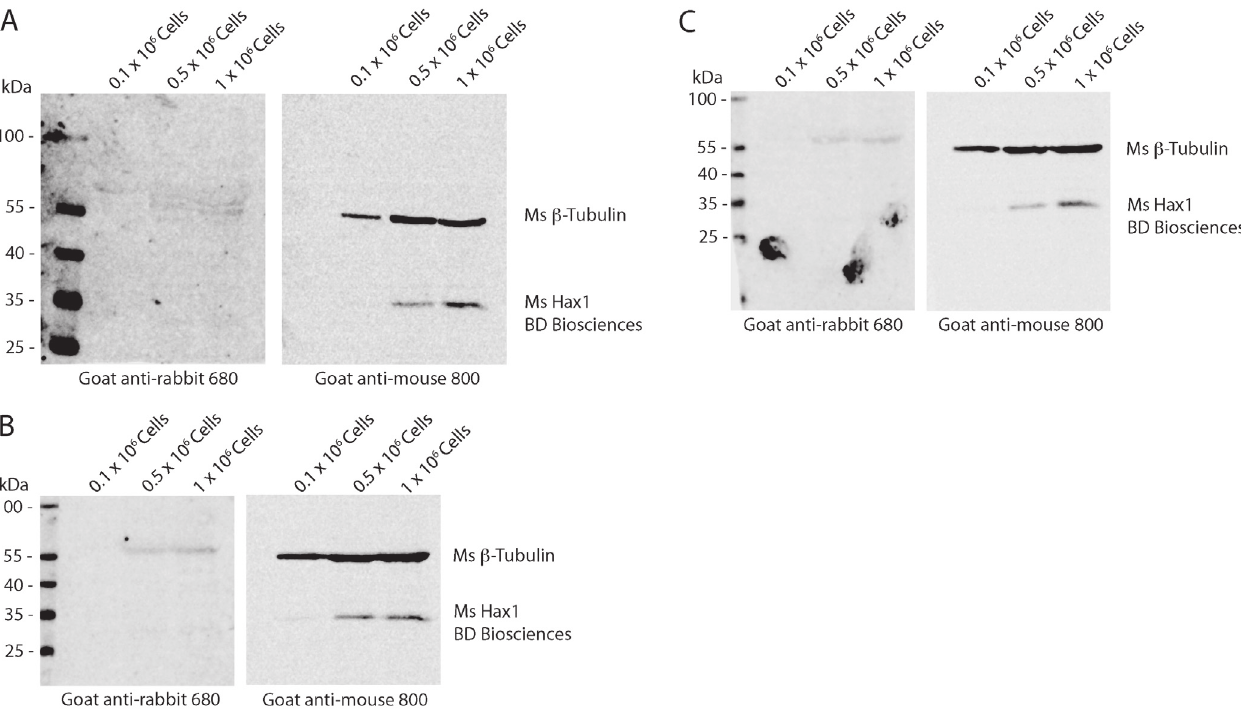
Figure 1. Detection of Hax1 in differentiated PLB-985 cells using a mouse anti-Hax1 antibody. Western blot analysis of differentiated PLB-985 cell lysates from 0.1 × 10 6 , 0.5 × 10 6 , and 1 × 10 6 cells from three independent replicates. Mouse anti-tubulin (beta-) is used as a loading control and can be seen present at a relative mobility of 55 kDa in the goat anti-mouse 800 channel. Mouse anti-Hax1 detects a band with a relative mobility of 35 kDa as predicted. Hax1 can be detected in densities of 0.5 × 10 6 and 1 × 10 6